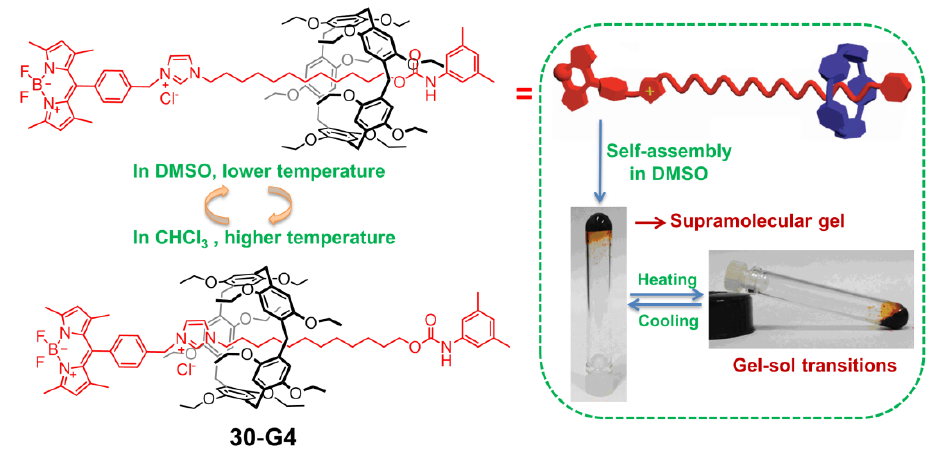
Figure 21. Multistimuli sensitive behavior of BODIPY-involved fluorescent [2]rotaxane 30 - G4 and its corresponding self-assembly of supramolecular gel in dimethylsulfoxide (DMSO).